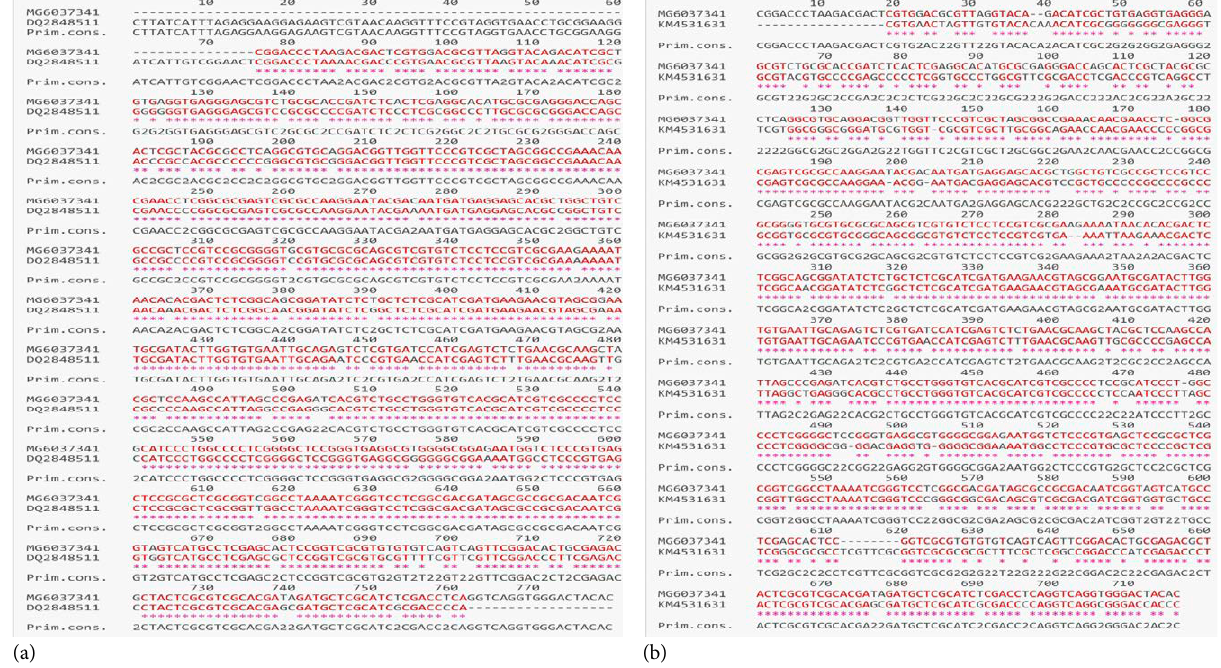
Fig. 2. (a) Sequence alignment between cf. Ceiba sp. and Ceiba pentandra (accession no. DQ284851) using CLUSTAL W, Identity (*): 625 is 80.23 %. (b) Sequence alignment between cf. Ceiba sp. and Bombax ceiba (accession no. KM453163 ) using CLUSTAL W, Identity (*): 548 is